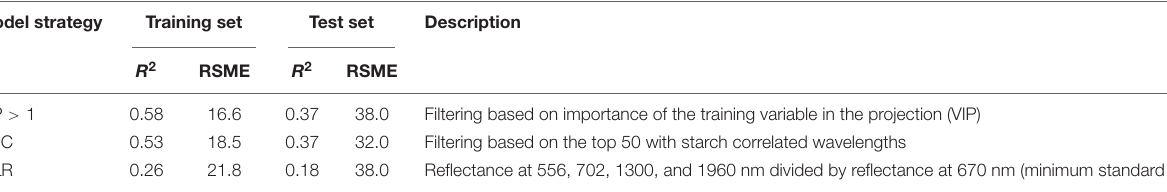
TABLE 1 | Model performance using different filtering